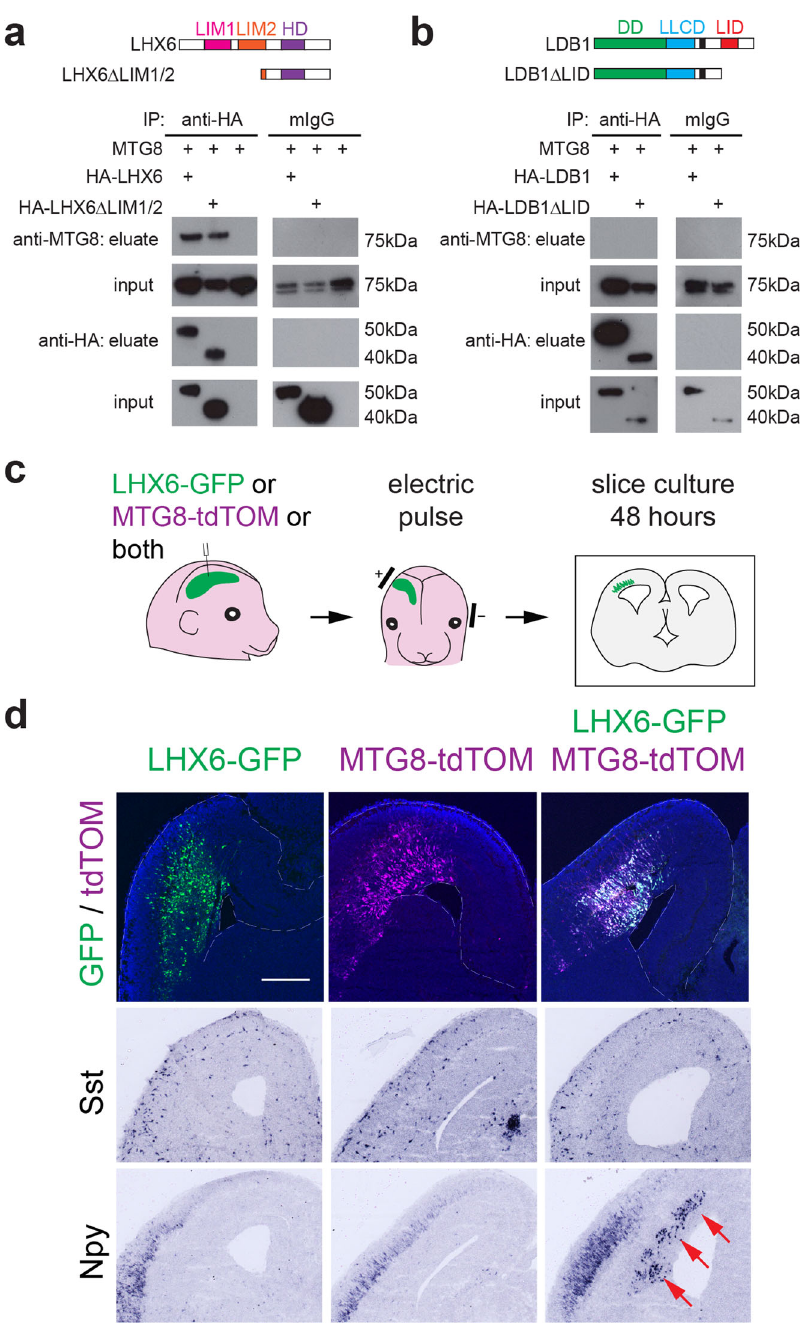
Fig. 5| MTG8interactswith LHX6 topromoteSST-NPYfate.a Domainstructure of LHX6 and the truncated LHX6 protein used in this study, LHX6 Δ LIM1/2, which lacks both LIM domains. Immunoprecipitation of WT or truncated LHX6 results in co-IP of MTG8 in transient transfection assays in Cos cells. Uncropped blots are provided as aSource Data fi le. b DomainstructureofLDB1and the